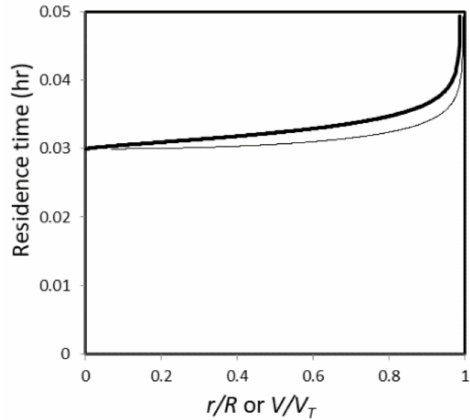
Figure 3. Residence time within a column as function of dimensionless radius ( r / R ) and dimensionless volume ( V / V T ) (media: Capto Q, dimensions: 30 mm diameter and 12.7 mm bed height, bed volume: 9 mL, flow rate: 5 mL/min, superficial velocity = 42 cm/h).